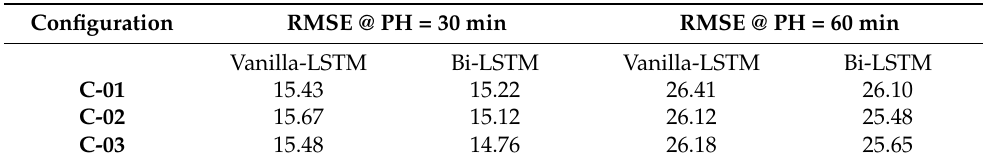
Table 3. Prediction error using different input feature configurations at 30 min and 60 min PHs for patient 570.